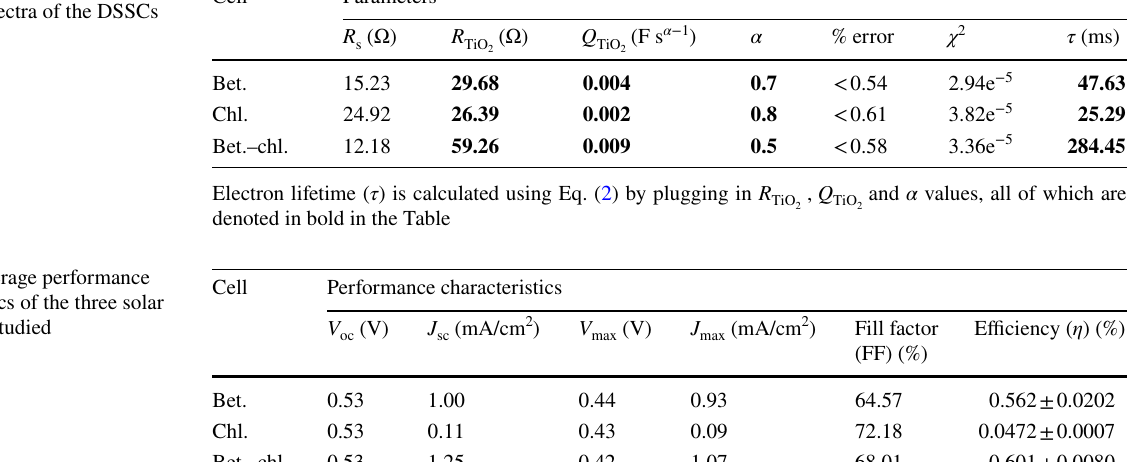
from EIS spectra of the DSSCs